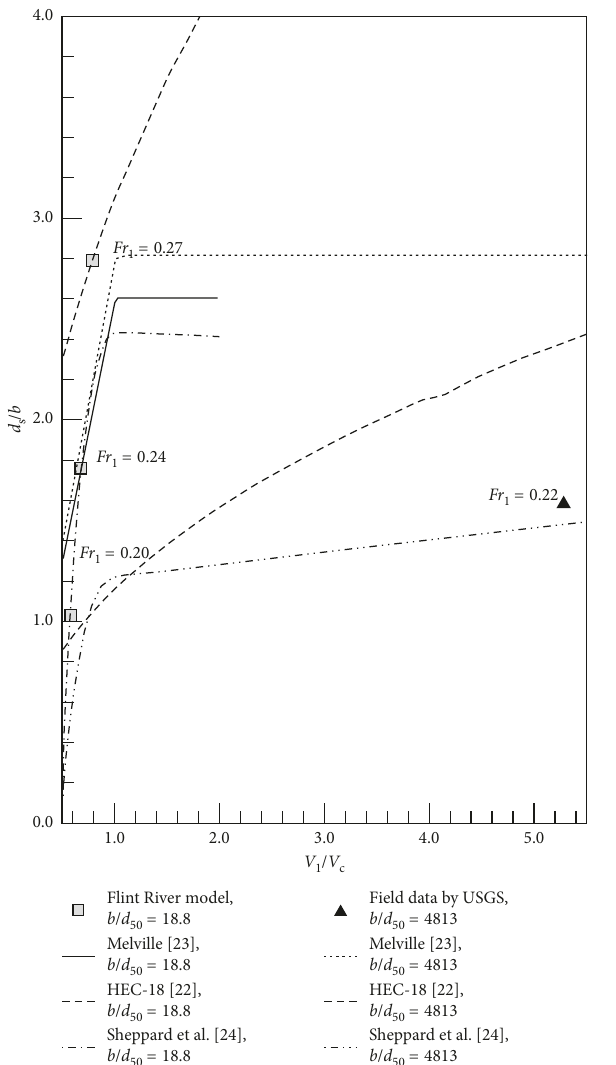
Figure 9: Comparison of field and laboratory measurements of scour depths and scour prediction formulas for Chattahoochee River